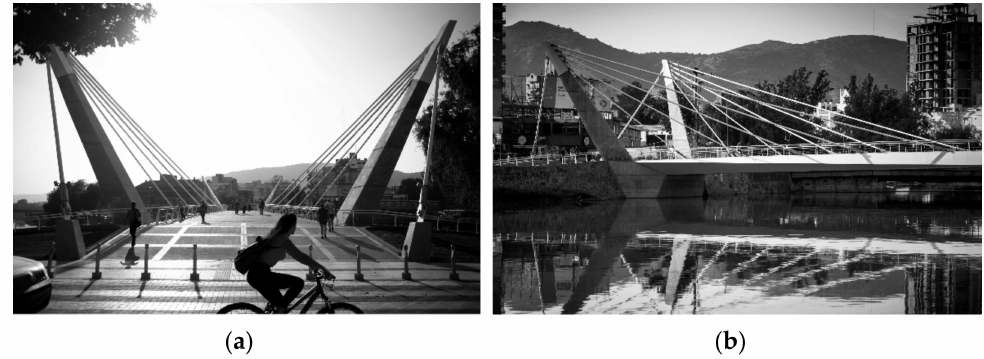
Figure 14. ( a ) Masts raising upwards and outwards resemble welcoming ‘open arms’. ( b ) Masts, abutment walls, and foundations form an integral